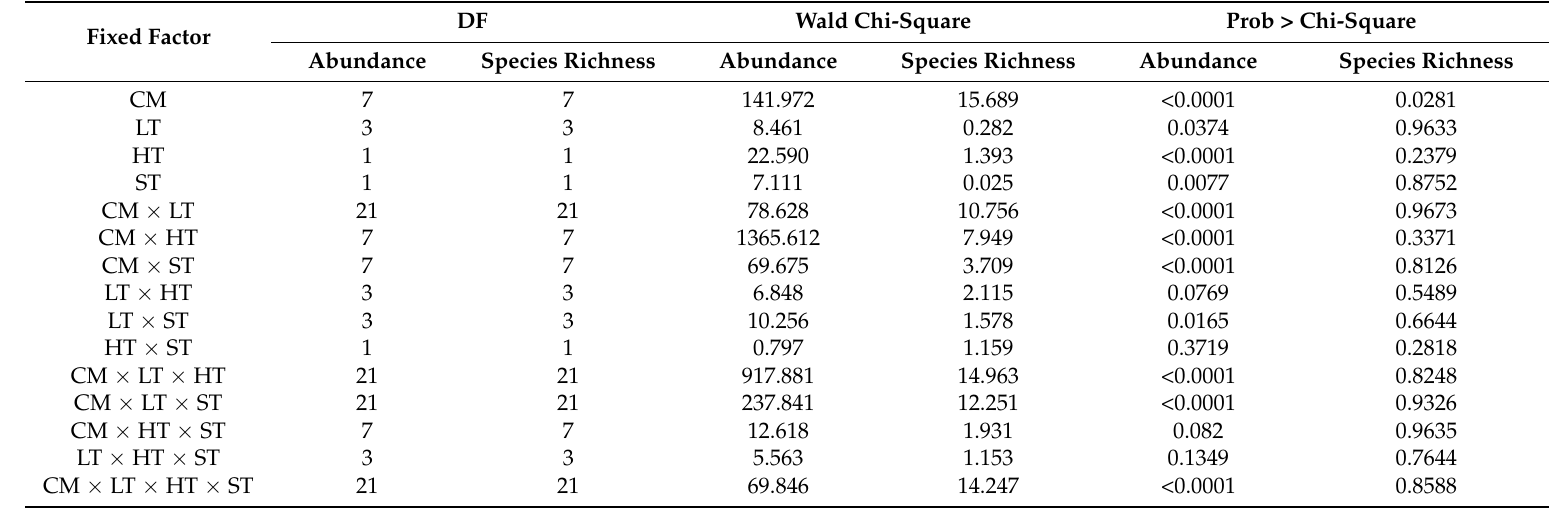
Table 1. Two-way analysis of variance (ANOVA) assuming zero inflated Poisson distributions (ZI Poisson) for mean abundance and mean species richness per